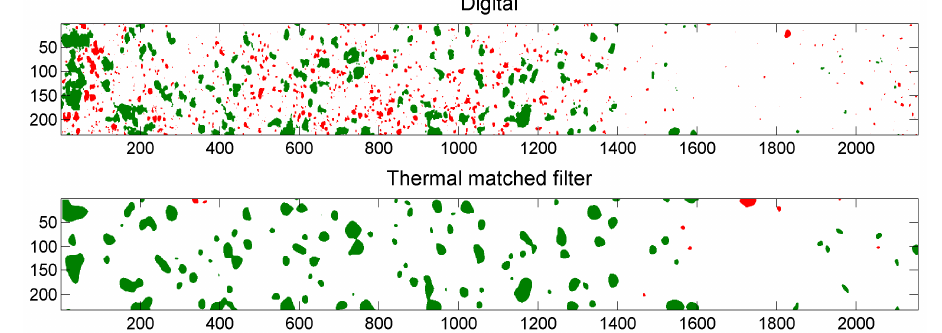
Figure 10. Binarized digital image ( top ); and binarized thermal output image “matched filter” ( bottom ). Coordinates are shown in pixels. Particles that occur in both images are shown in green. Particles that occur only in the digital image or only in the thermal output image are shown in red in respectively the top image and the bottom image.